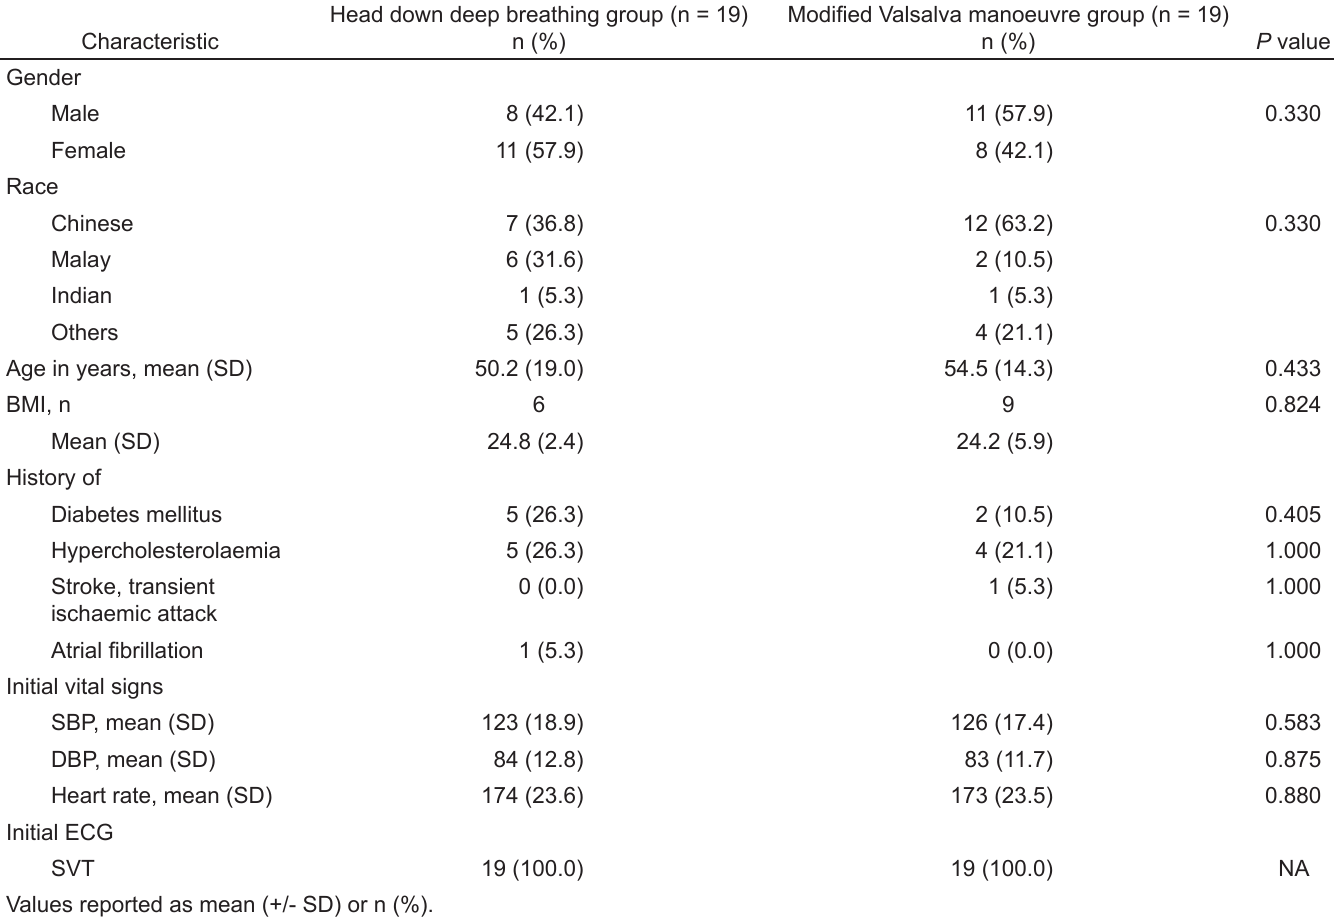
Table 1. Baseline characteristics and initial vital signs.